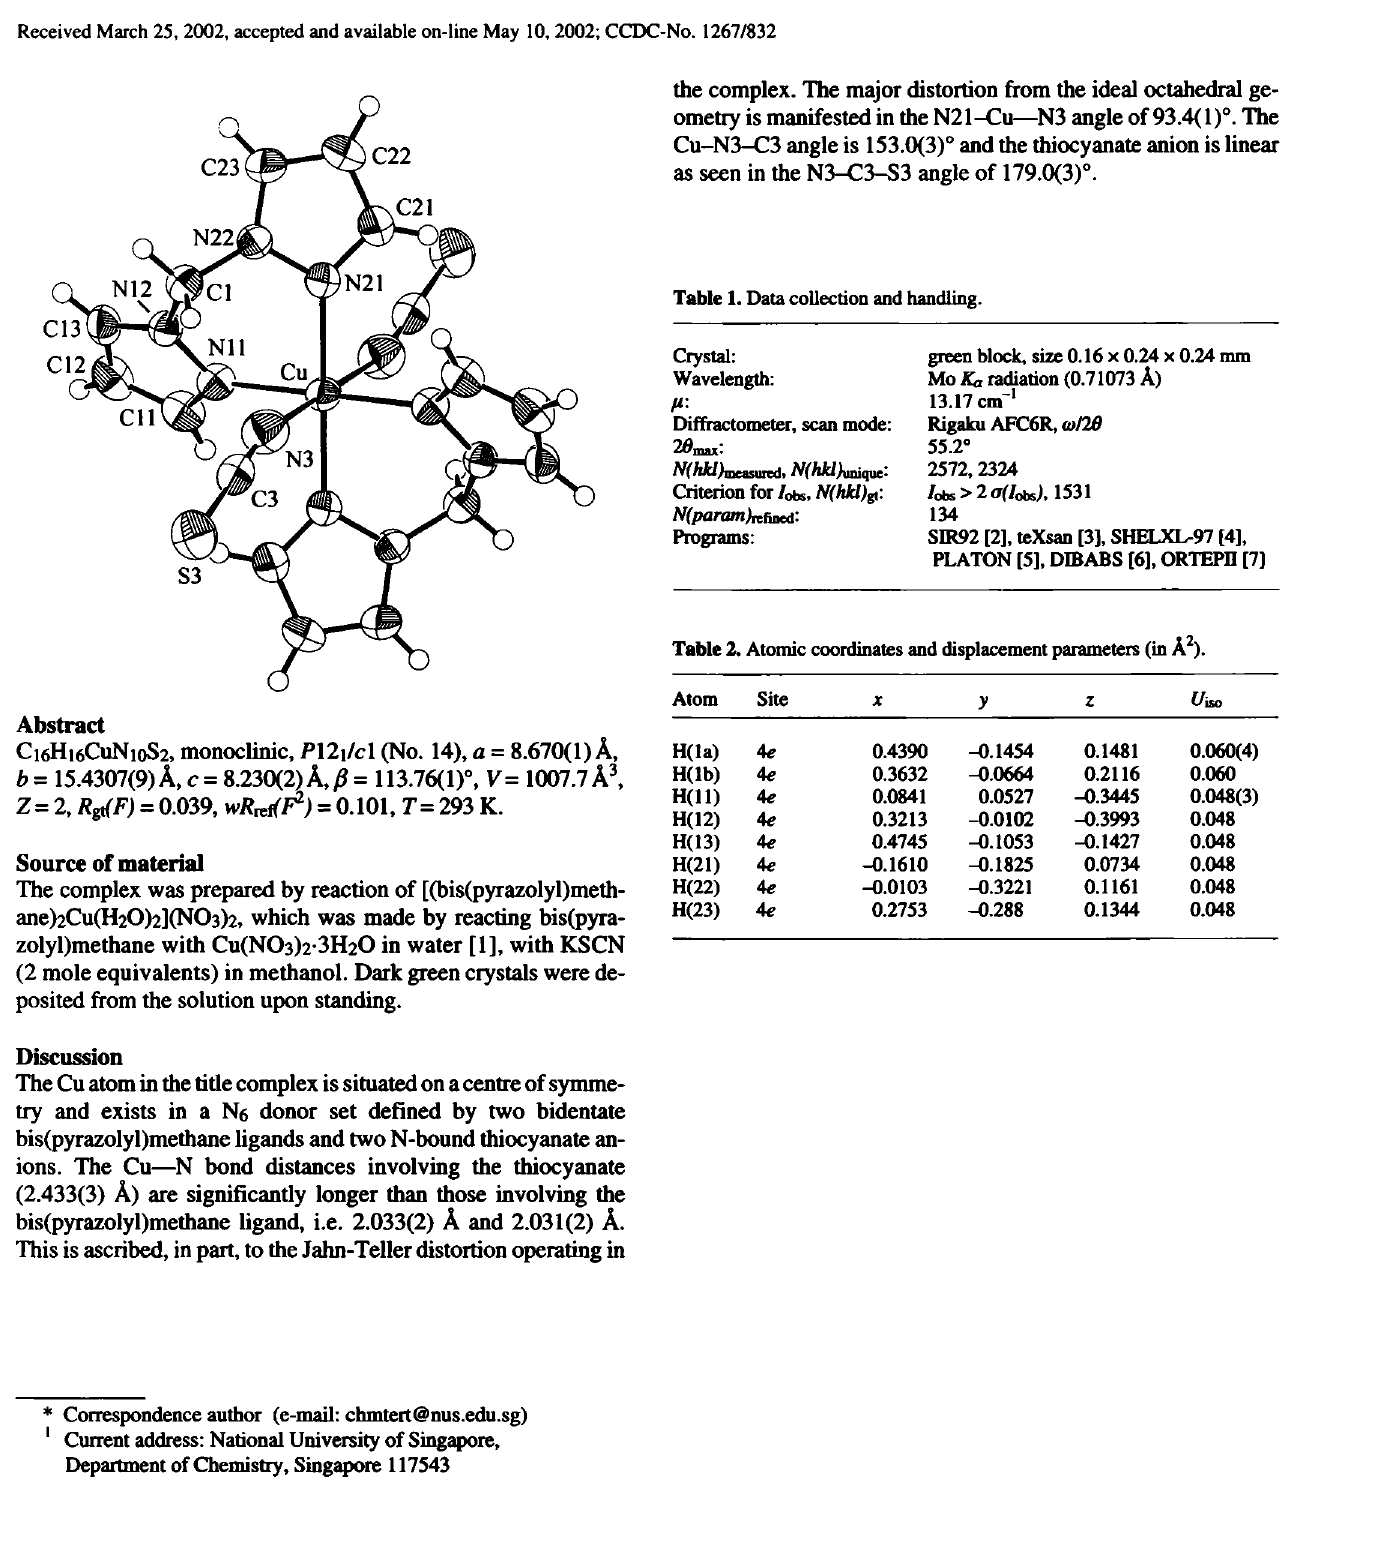
Table 1. Data collection and handling.